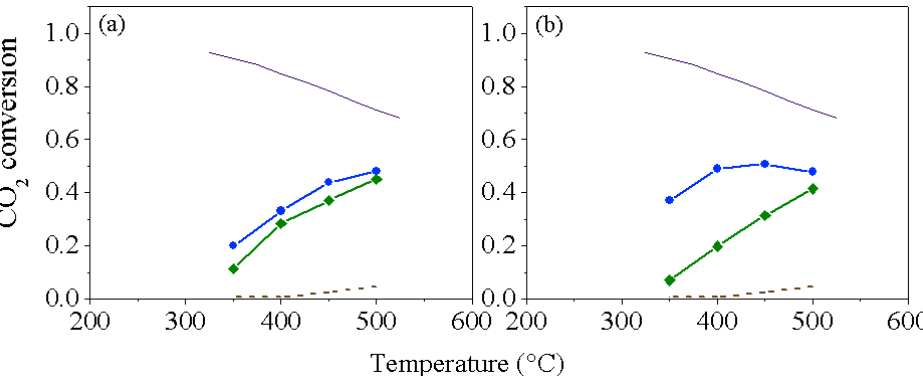
Figure 5. Effect of the preparation method of zirconia supports on CO 2 conversion: ( a ) 10% Ni content, ( b ) 20% Ni content. ( ) ZrO 2-COP , ( (cid:7) ) ZrO 2-SG , (dashed line) SiC, (solid line) equilibrium conversion.